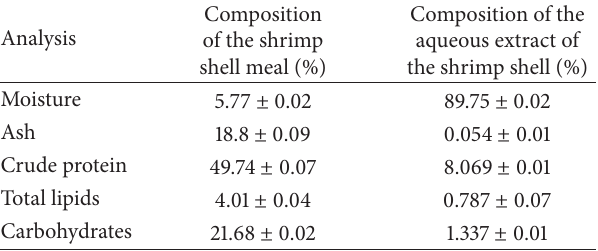
Table 2: Compositions of the culture media used for growth of the Xanthomonas campestris strains and for fermentation to produce xanthan gum.